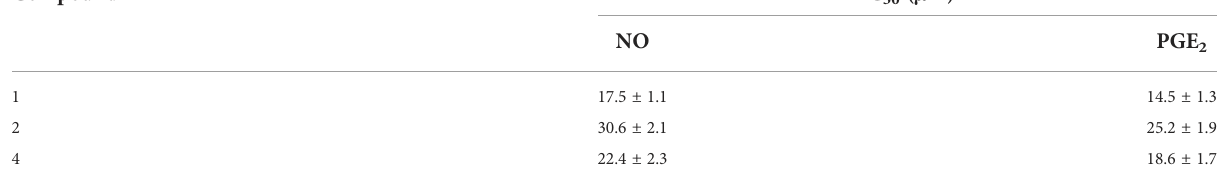
TABLE 3 Inhibitive activity on NO and PGE 2 production for compounds 1 - 2 , 4, and 6 . Compound